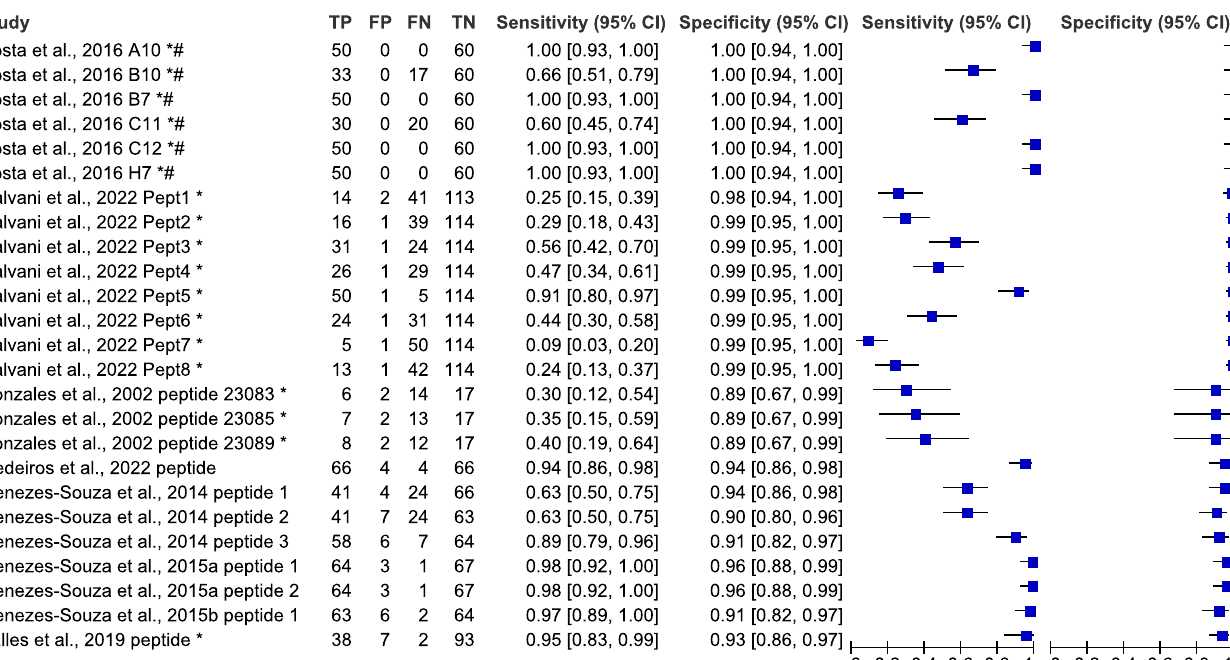
Figure 3. Forest plot representing percentage of sensitivity and speci fi city of different peptide-based tests for tegumentary leishmaniasis (TL=CL+ML) diagnosis. * studies where the counts of true positive (TP), false positive (FP), false negative (FN), and true negative (TN) results were estimated from the sensitivity and speci fi city values. # studies where sensitivity and speci fi city were recalculated considering all non-cases in a single control group.